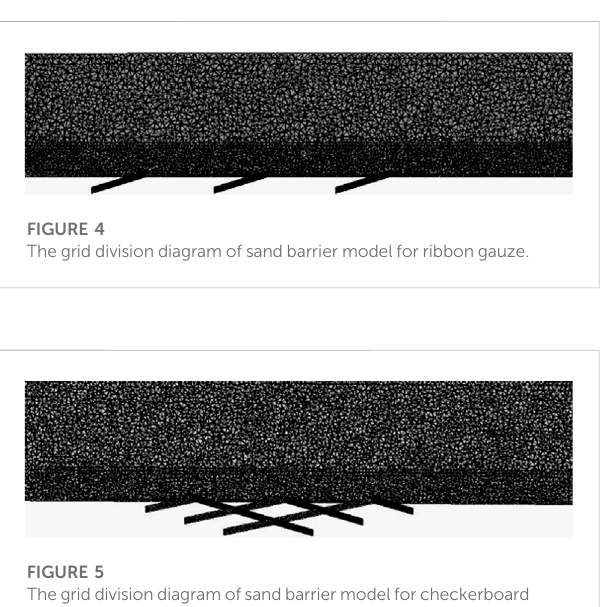
FIGURE 5 Thegriddivisiondiagramofsandbarriermodelforcheckerboard